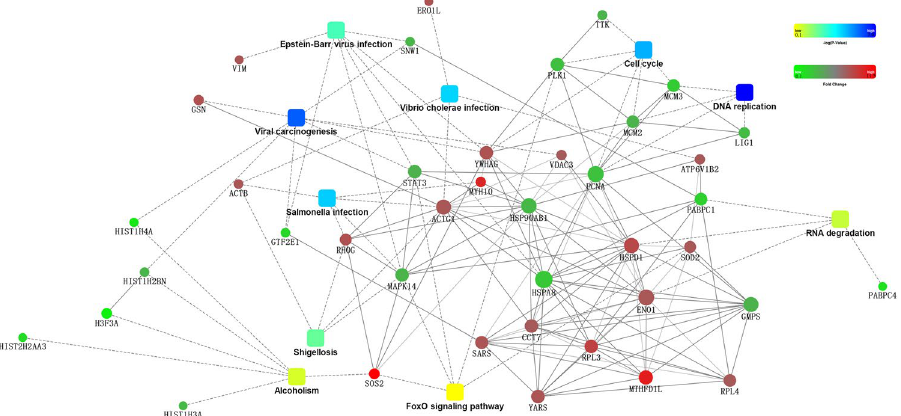
Figure 6. PPI network of differentially expressed proteins constructed in STRING database. The solid lines represent direct interactions between proteins, and the dotted lines indicate indirect interactions between proteins. The dots stand for differentially expressed proteins, different colors shows FC of identified proteins, different diameter representative the number of proteins interacted with the protein. The squares stand for differentially expressed proteins involving in GO or KEGG